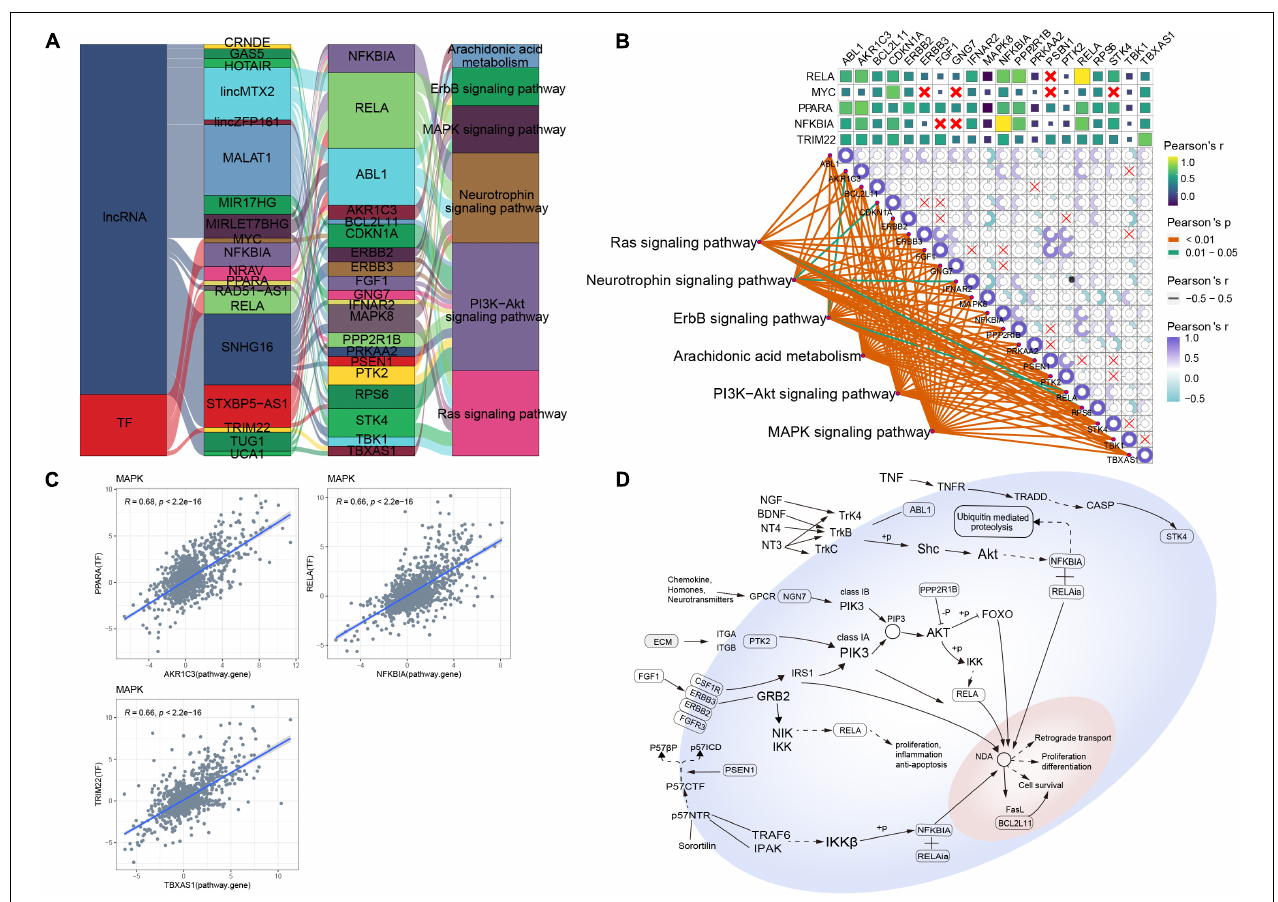
FIGURE 3 | Potential regulatory mechanism of mitogen-activated protein kinase (MAPK)-type Alzheimer’s disease (AD). (A) Sankey diagram showing the pathways of MAPK-type AD regulated by long non-coding RNAs (lncRNAs) and transcription factors (TFs) identified using the RNAInter and TRRUST databases. (B) Correlation pathway diagram of the gene–pathway, gene–gene, and TF–gene correlations. (C) Correlation scatter plot of the correlations between the TFs PPARA, RELA, and TRIM22 and their respective target genes AKR1A3, NFKBIA, and TBXAS1. (D) Potential regulatory mechanism of MAPK-type AD.